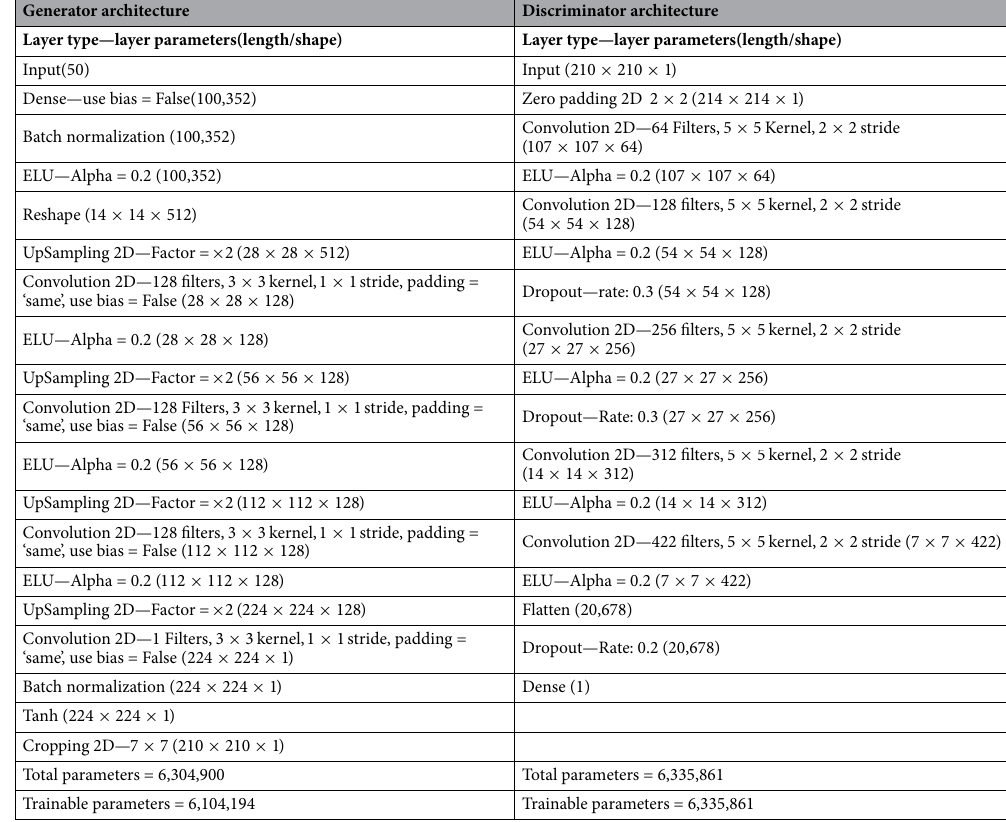
Table 7. WGAN architecture with intermediate layer shapes and